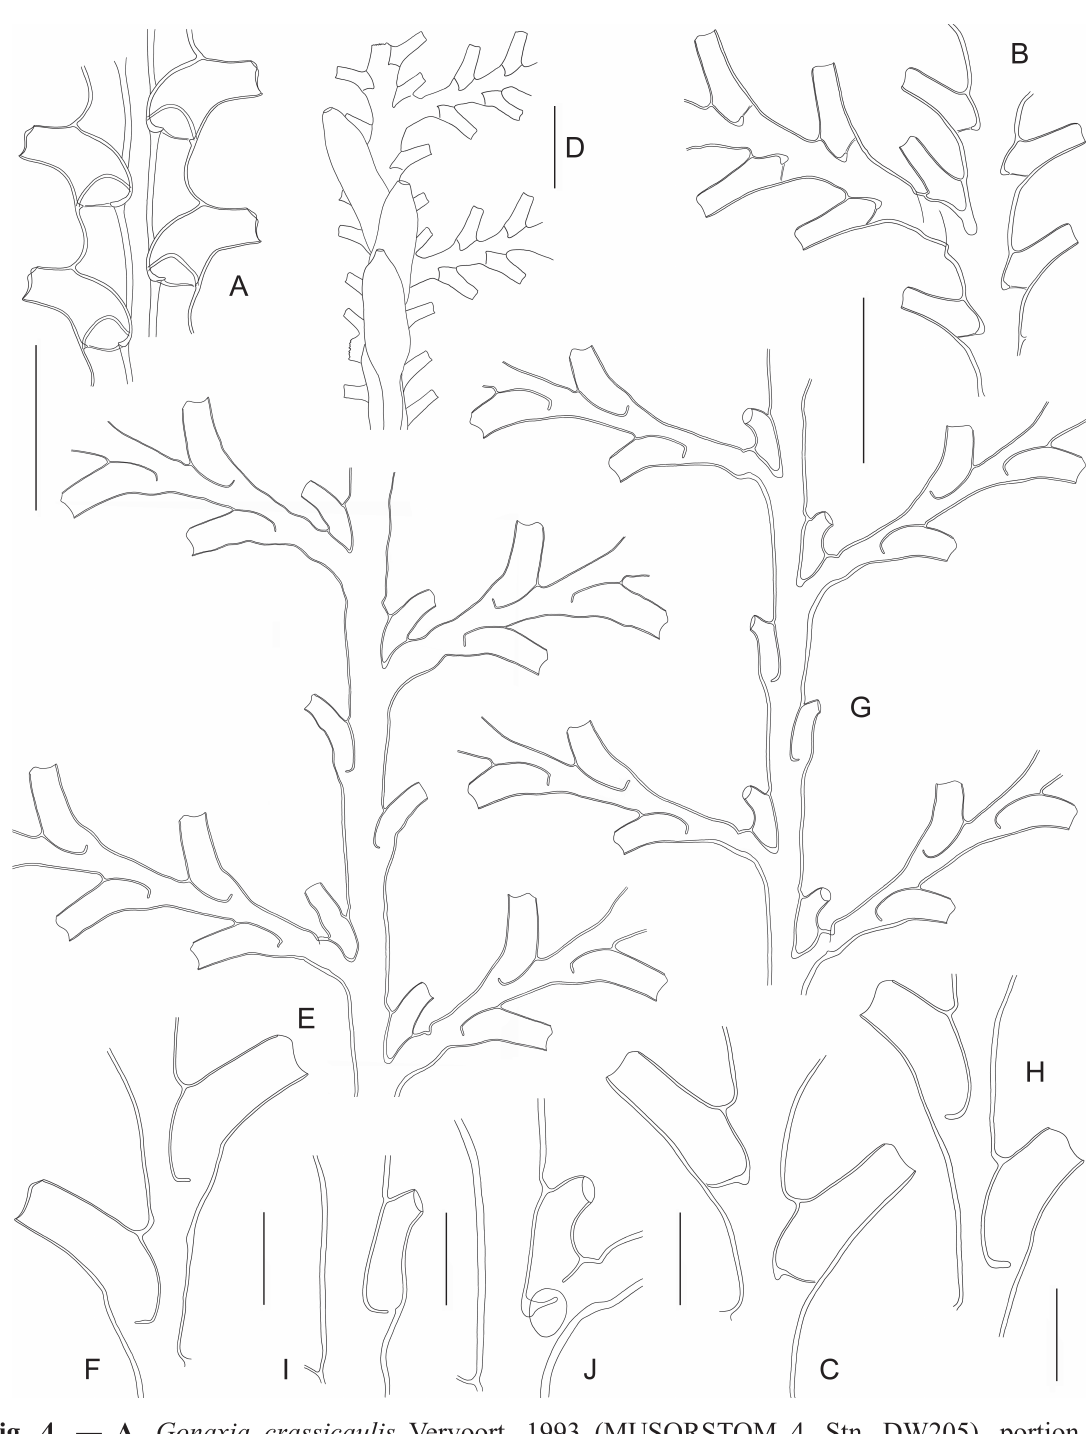
Fig. 4. ― A . Gonaxia crassicaulis Vervoort, 1993 (MUSORSTOM 4, Stn. DW205), portion of cladium. ― B–D . Gonaxia elegans Vervoort, 1993 (BATHUS 3, Stn. DW809). B . Portion of stem and basal part of a cladium. C . Two consecutive internodes with their hydrothecae. D . Portion of stem with male gonothecae. ― E–F . Gonaxia cf. errans Vervoort, 1993 (BATHUS 2, Stn. CP737). E . Distalmost portion of stem with basal parts of four hydrocladia. F . Two consecutive cladial internodes with their hydrothecae. ― G–J . Gonaxia plumularioides sp. nov. (BIOCAL, Stn. CP34). G . Distalmost part of a stem, showing the structure of internodes. H . Two consecutive cladial internodes with their hydrothecae. I . Stem hydrotheca. J . Axillar hydrotheca. Scale bars: A–B, D–E, G = 1 mm; C, F, H–J = 300